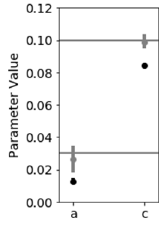
Figure 10. The parameter estimate are shown: the vertical bars indicate the 95% HDI. Black bars represent the HDI corresponding to the fit result shown in Figure 9A and gray bars represent the HDI corresponding to the fit result shown in Figure 9B.